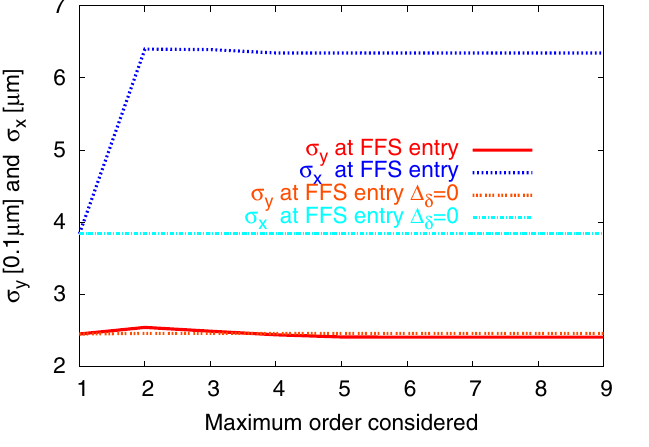
FIG. 3. (Color) Horizontal and vertical rms beam sizes at the end of the CLIC collimation section as a function of the maximum order considered in the transfer map. Both the nominal and monochromatic beams are considered. The horizontal aberra- tions are purely chromatic.